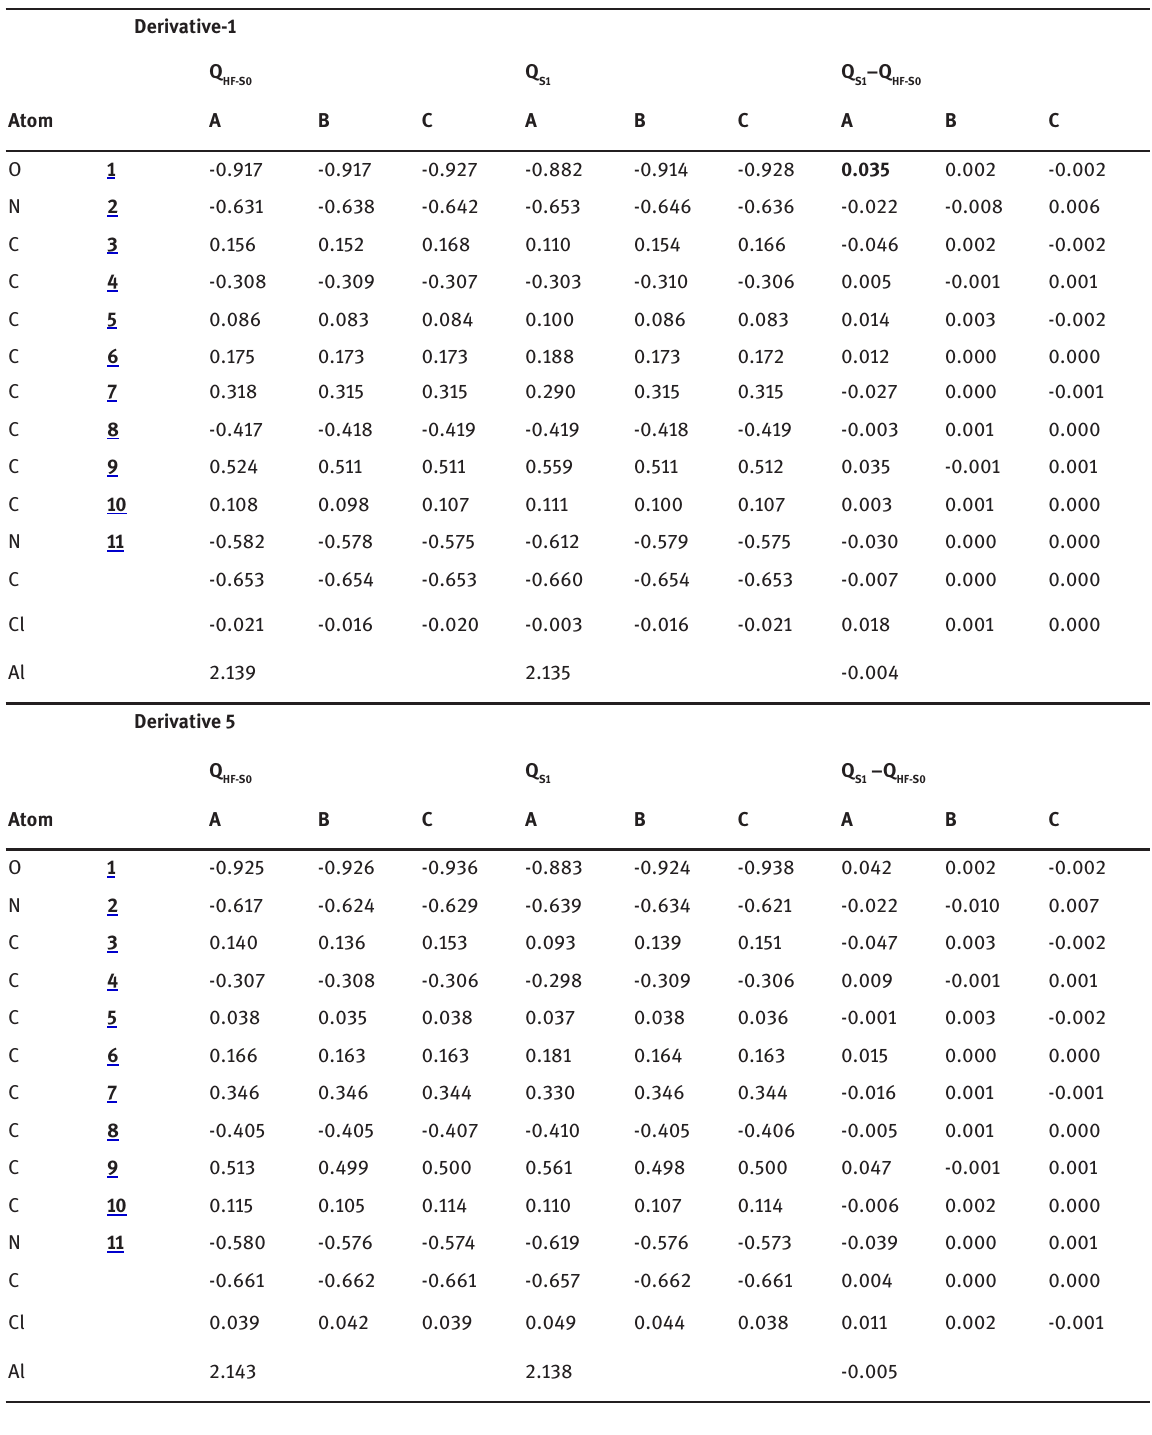
Table 4: The NBO charges (Q) of the ligands in 1 and 5, in the optimized ground (Q differences between Q and Q states calculated at the HF/6-31G(D) and CIS/6-31G(D) methods, respectively (for atom labels see Fig. S4) HF-S0 S1 (for EDG and EWG labels are not